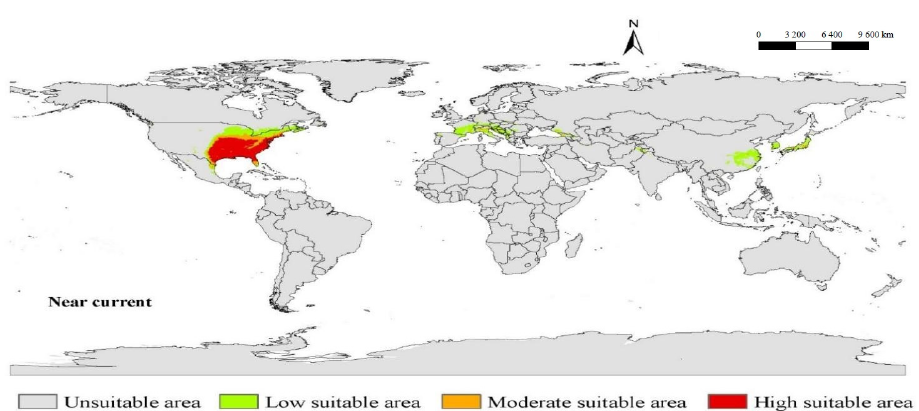
Figure 3. Predicted area suitability under near current climatic conditions. The predicted potential geographic distribution of A. americanum is not only in the current occurrence area.